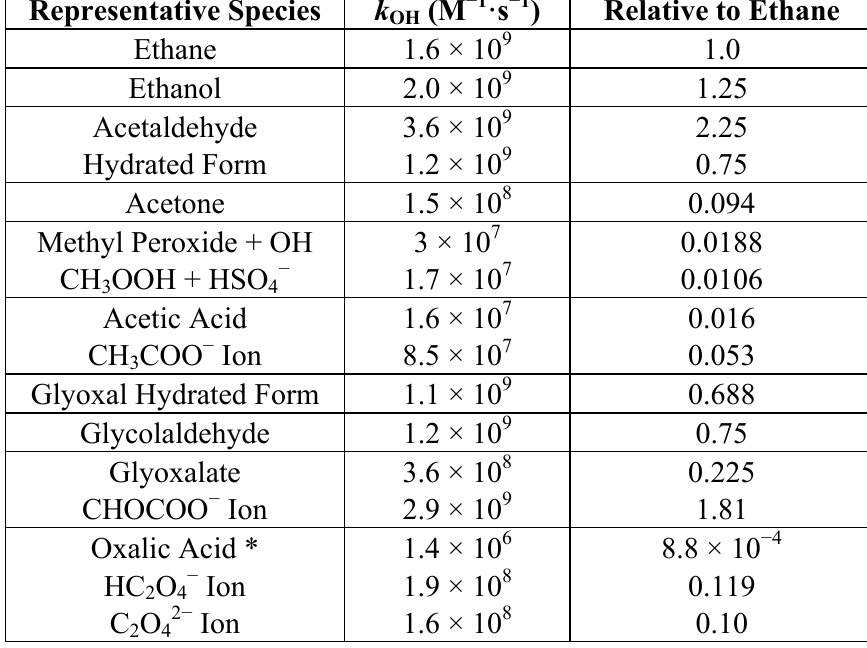
Table 3. OH-initiated aqueous oxidation of representative organic compounds with different functional groups (298